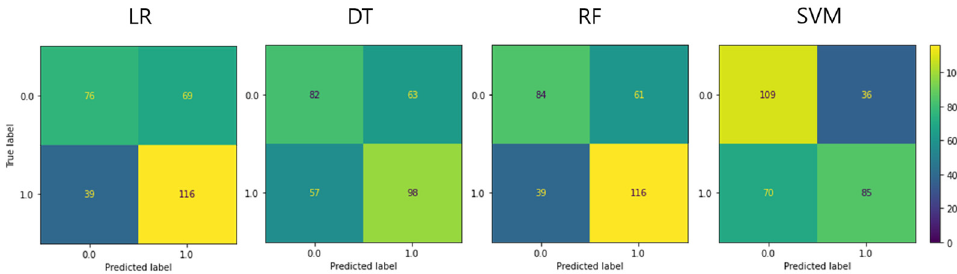
Figure 1. Confusion matrix of each machine-learning model in the test set. LR, logistic regression; DT, decision tree; RF, random forest; SVM, support vector